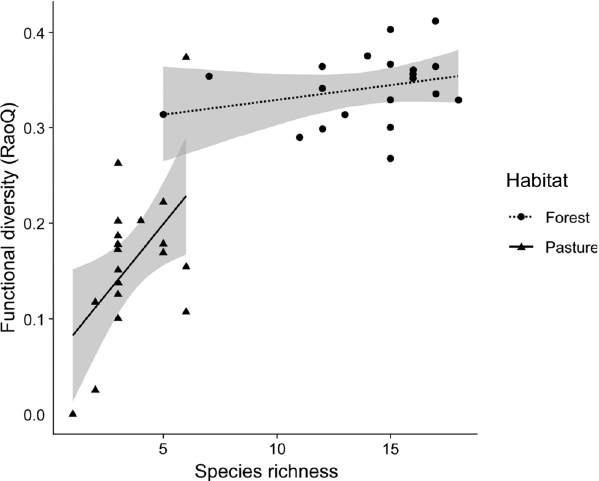
Fig 3. Relationship between functional diversity (Rao’s Q) and observed species richness in the plots of each habitat type (forest: intercept value = 0.29927, slope value = 0.00304 and pasture: intercept value = 0.05334, slope value = 0.02929), in southwestern Brazilian